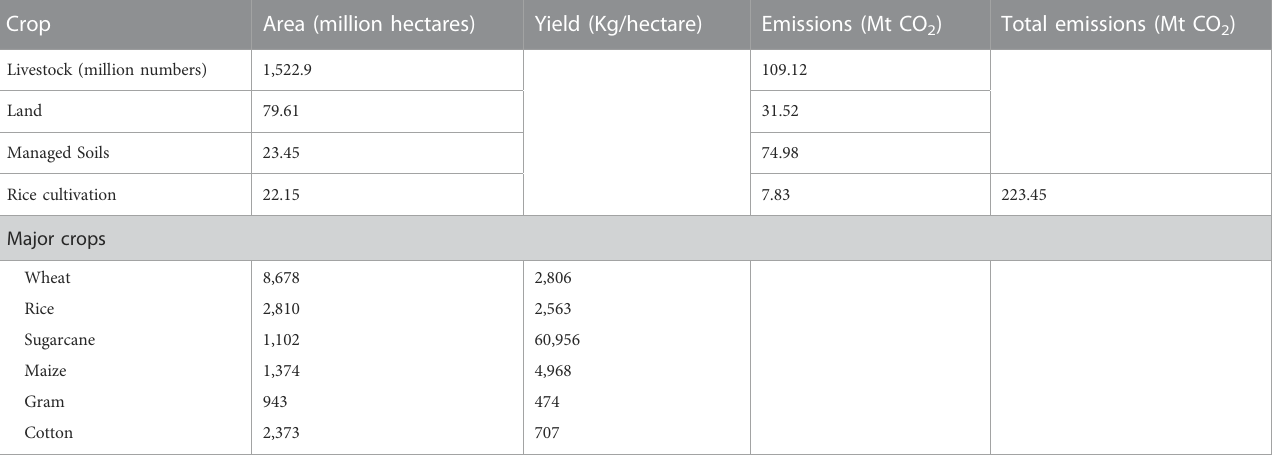
TABLE 3 Comparison of carbon emission footprint between different crops in Pakistan (Pakistan Economic Survey, 2020; Nationally Determined Contribution, 2021) 3 .